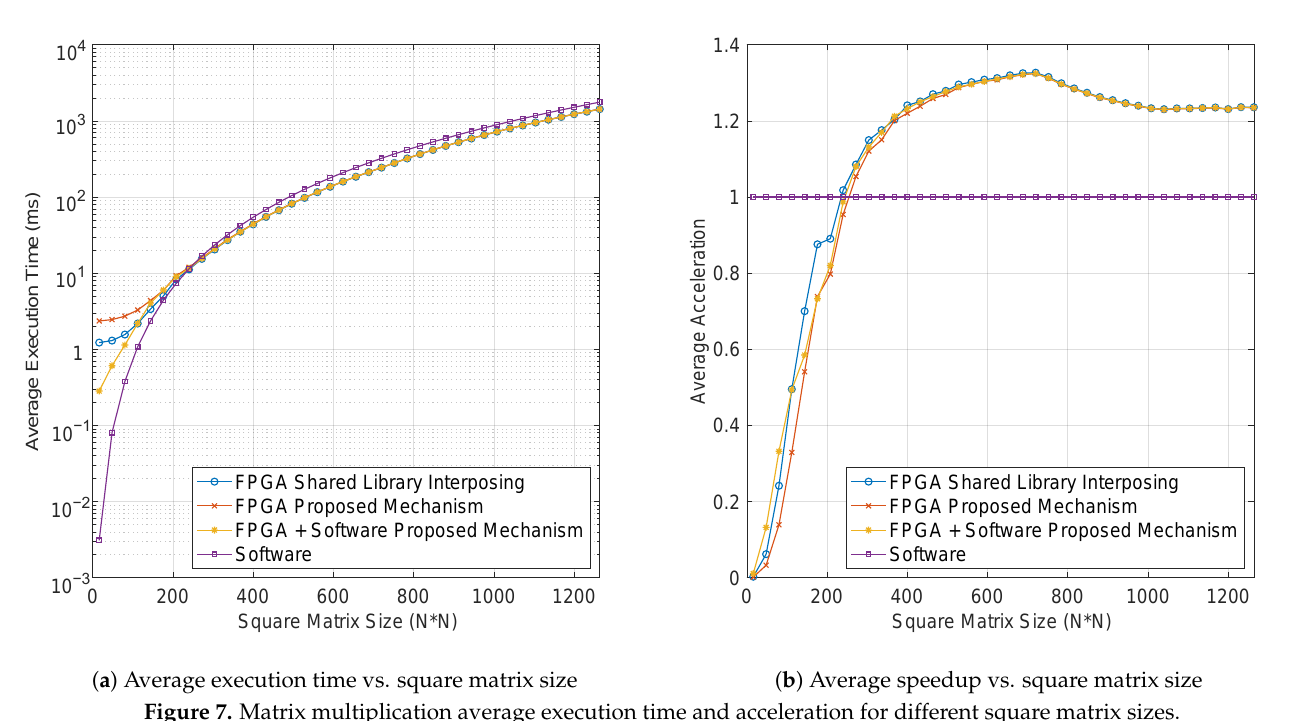
Figure 7. Matrix multiplication average execution time and acceleration for different square matrix